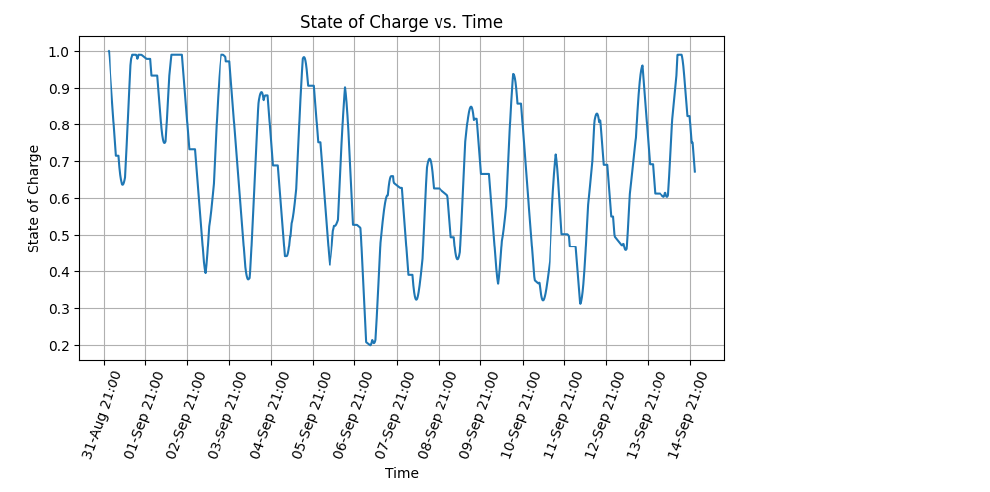
Figure 12. Excess power for a microgrid with 174 kW photovoltaic power rating and 1211 kW